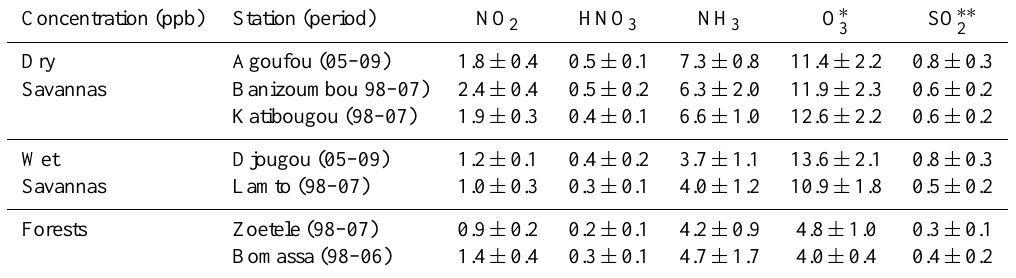
Table 2. Mean annual concentrations (in ppb) at IDAF sites over the study period (1998–2007) (adapted from Adon et al., 2010).